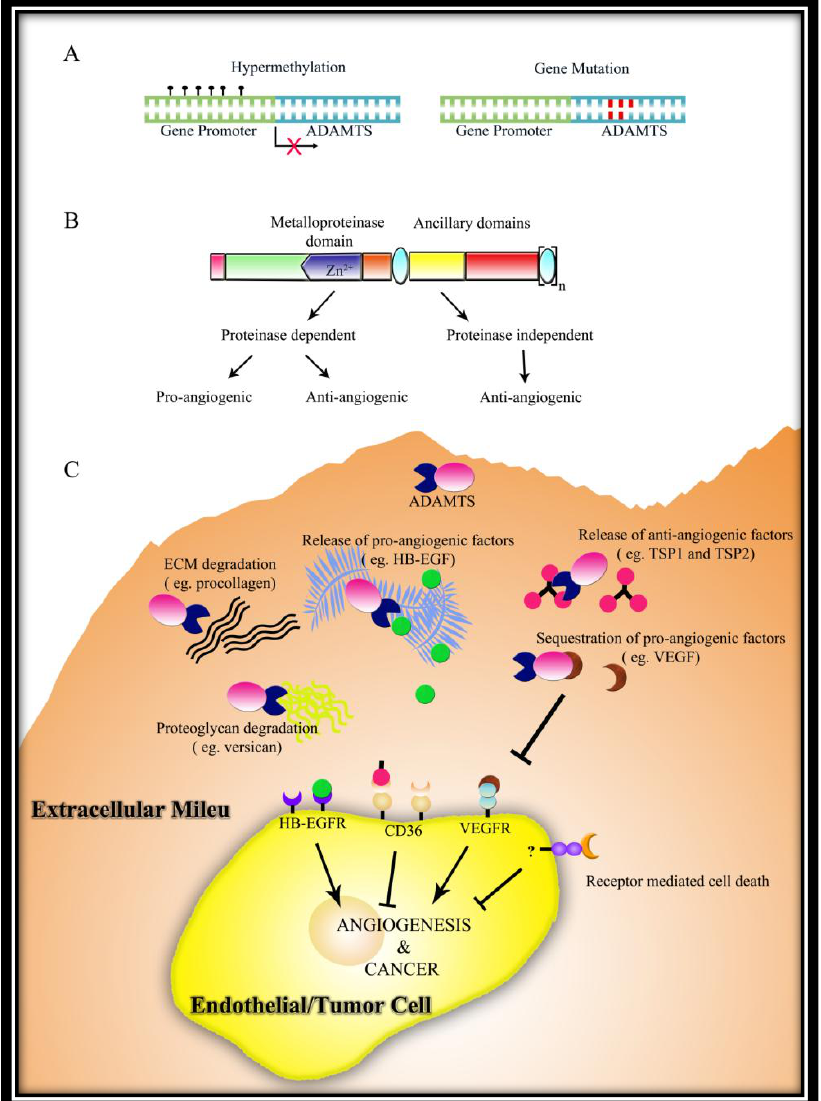
independent sequestration of pro-angiogenic factors (ADAMTS1); (ADAMTS5) anti-angiogenesis and receptor mediated cell death